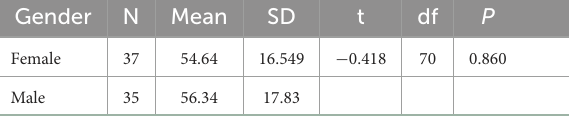
TABLE 3 According to gender-independent t -test scores.